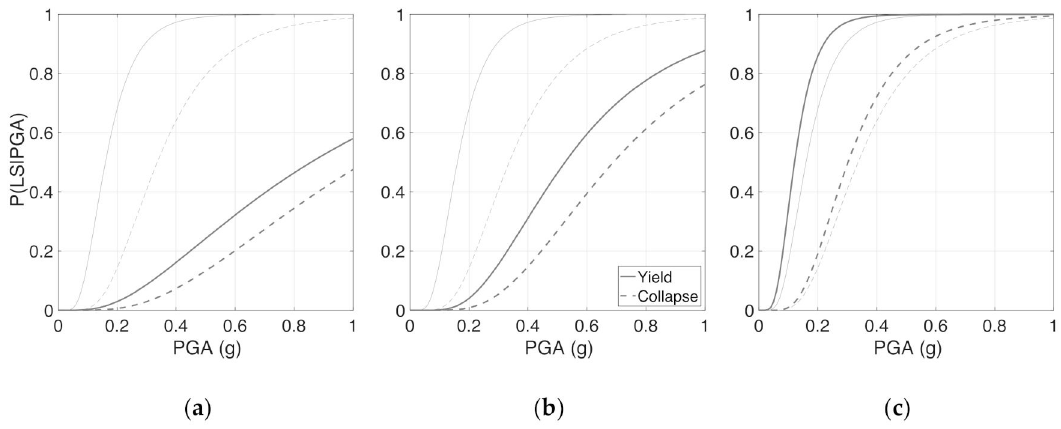
Figure 6. Fragility curves (thicker lines) for RC buildings with correlated parameters: ( a ) 91.5% fractile; ( b ) 50% fractile; ( c ) 8.5% fractile. The mean fragility curves are also displayed, with thinner